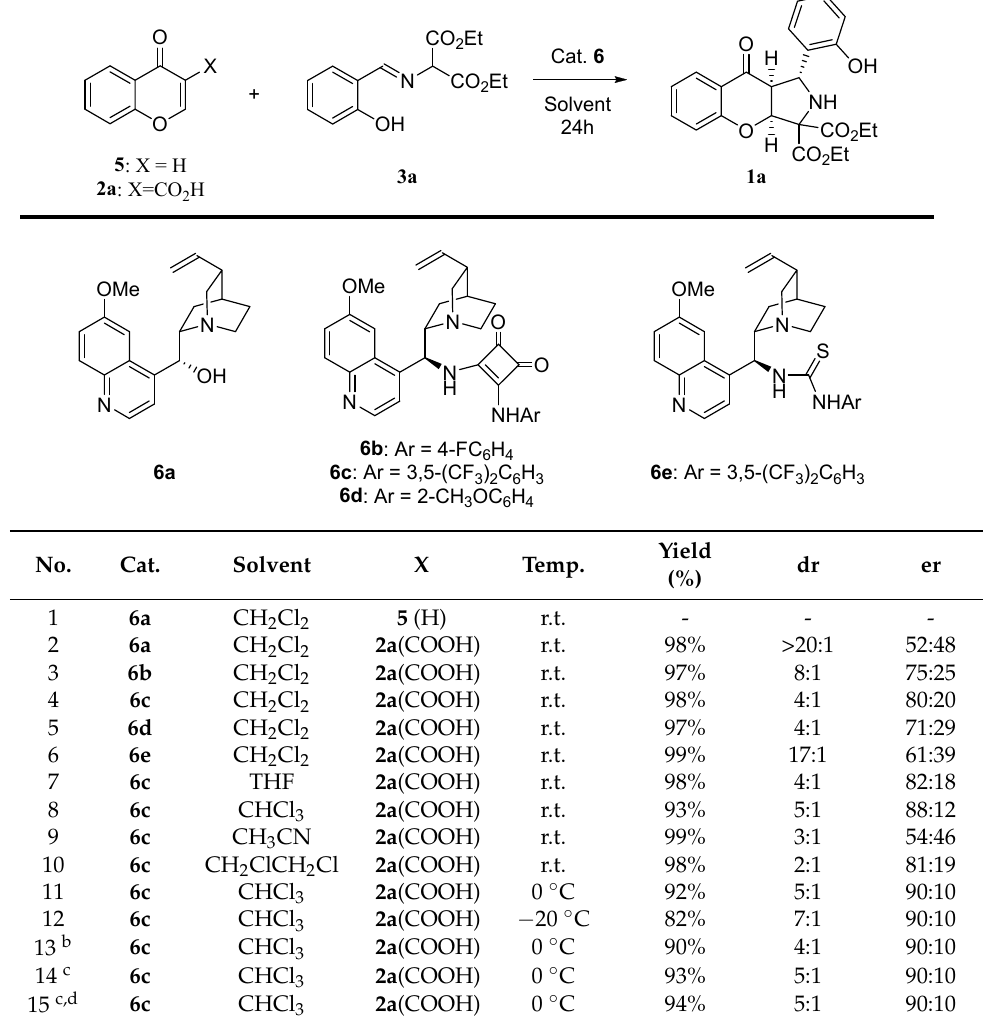
Table 1. Enantioselective (3+2)-cycloaddition of chromone-3-carboxylic acids 2 and diethyl iminomalonates 3 —optimization studies a .